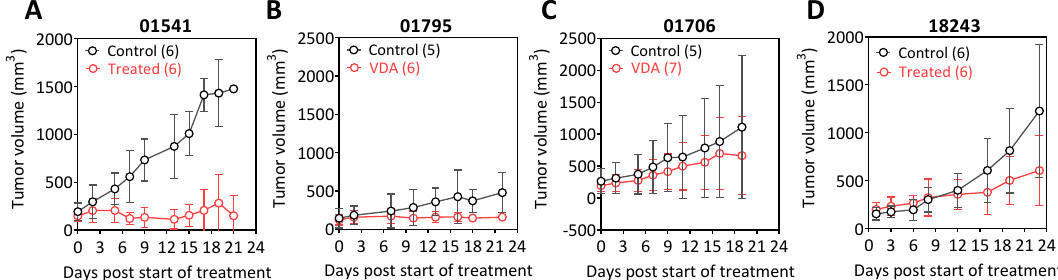
Figure 5. Response of p16 + and p16 − PDX models of HNSCC to vascular-targeted therapy. Temporal changes in tumor volumes in p16-negative 01541 ( A ), 01706 ( B ) and p16-positive PDX, 18243 ( C ), 01795 ( D ) models of HNSCC following treatment with the microtubule targeted vascular disrupting agent (VDA) EPC2407. Individual plots represent response of control (black circles) and EPC-treated tumors (red circles) for the four PDX models are shown. The p16 − PDX (01541) with the tumor vessel phenotype was the most responsive to vascular targeted therapy.